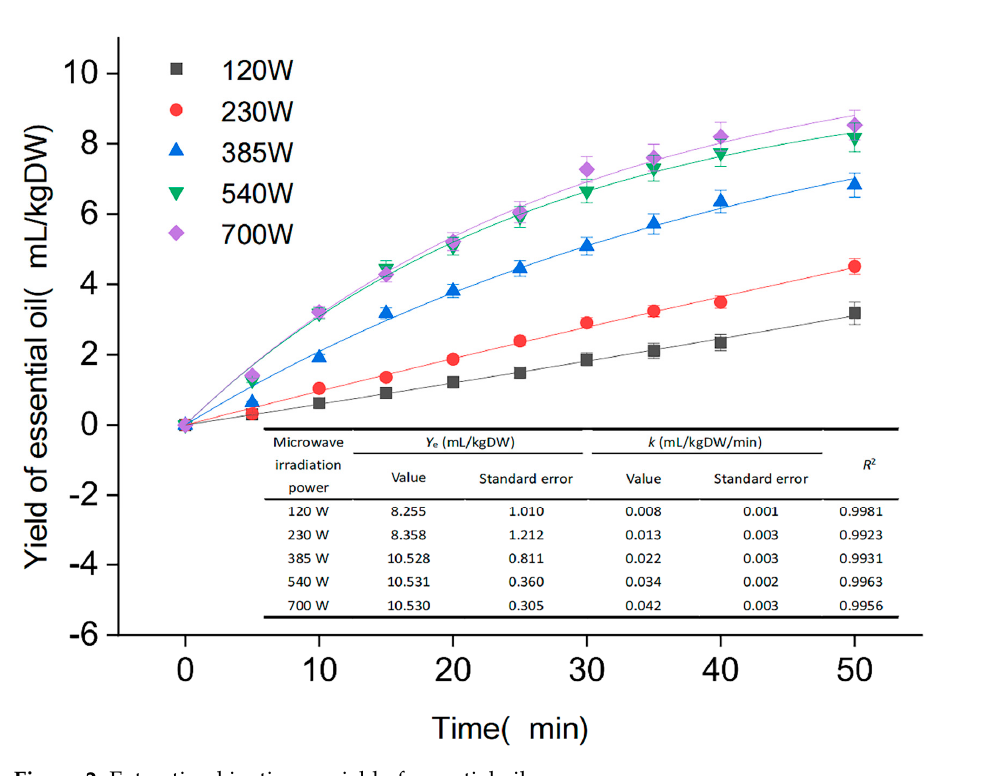
Figure 2. Extraction kinetics on yield of essential oil.